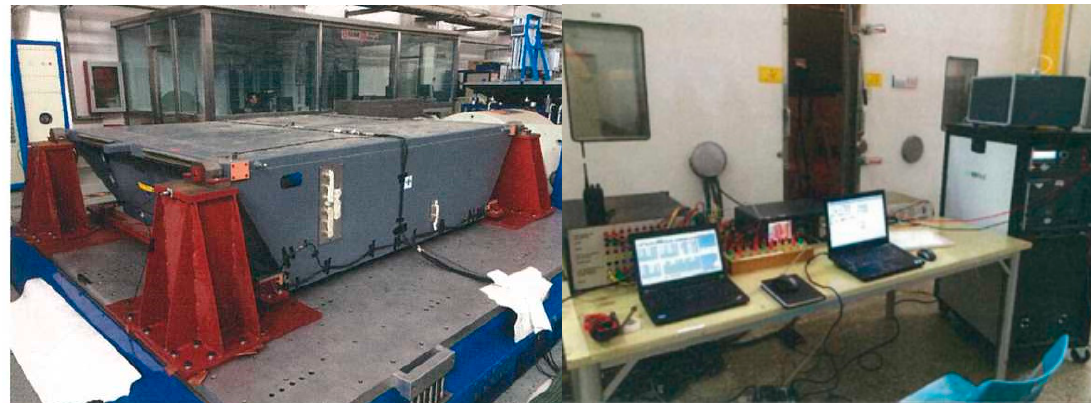
Figure 19. Standard EMU Experimental Platform.